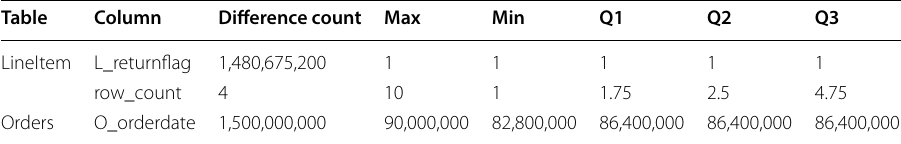
Table 11 Column validation statistics—“LineItem" and “Orders" tables Table